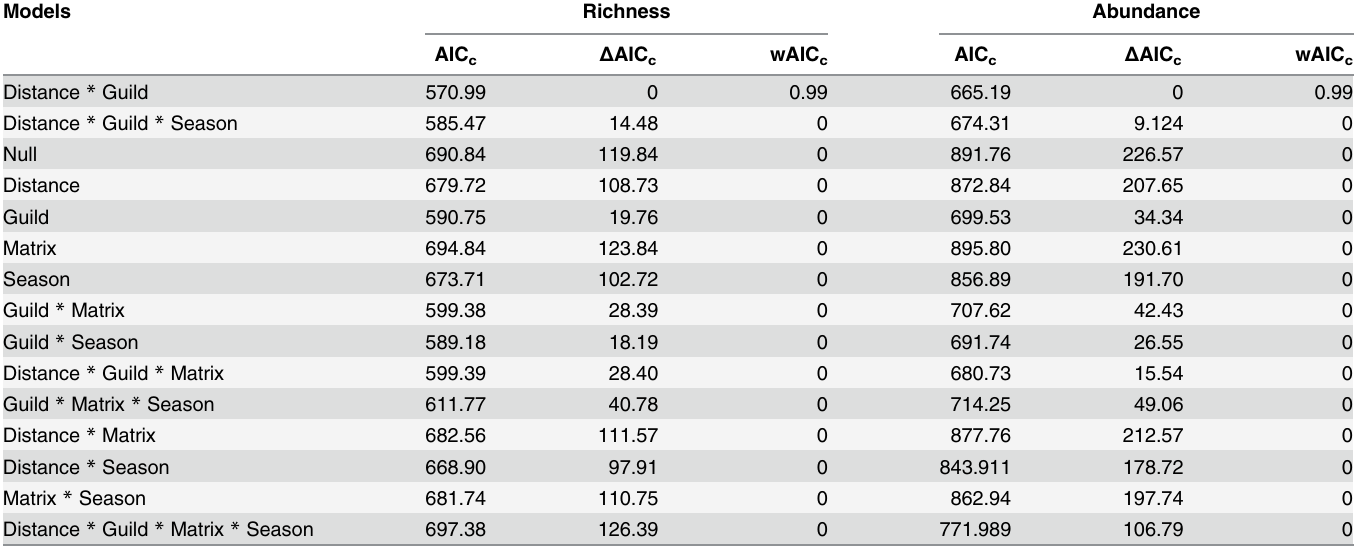
= 0.99) across the landscape (Table 1). ‘ Distance (cid:1) Guild ’ remained the best-fit- dance (wAIC c = 0.73) and abundance (wAIC = 0.74) even after excluding the ting model for richness (wAIC c c three most abundant species from the dataset ( A . glandulata , H . binotatus , and I . cf. parva 1 represented 68% of total individuals) (S2 Table). Furthermore, ‘ Guild ’ was the best-fitting model for richness and abundance by analyzing each distance inside the forest separately (S3 Table). Richness and abundance were higher in the rainy season regardless of ‘ Distance ’ (S1 Fig) or ‘ Guild ’ (S2 Fig). No environmental variable improved model fit for frog richness or abundance (Table 2). Within these environmental models, however, ‘ Distance (cid:1) Guild (cid:1) Large meliads ’ was the best model for abundance (wAIC = 0.89) (Table 2). c Leaf-litter breeders had higher richness and abundance at every distance as compared to bromeliad and water-body breeders in both dry and rainy seasons (Fig 2; S1 Table). Bromeliad Table 1. Model comparison of frog richness and abundance. Response variables evaluated in relation to 'Breeding guild', 'Distance', 'Matrix type', and 'Season' across 21 sites in the mountainous region of Brazil ’ s Atlantic Forest.